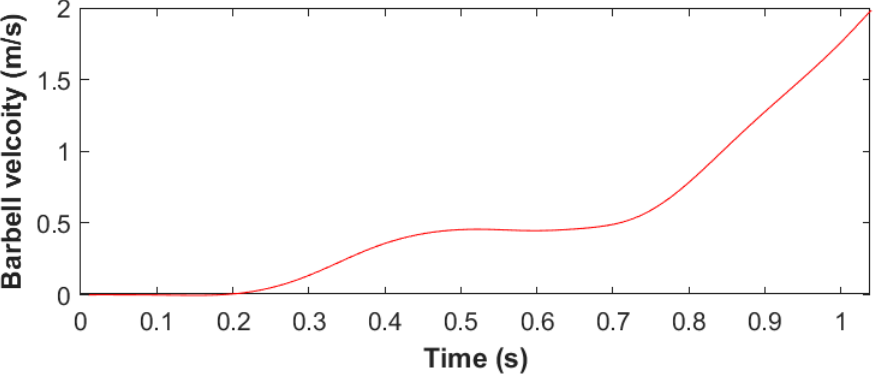
Figure 3. Example of a velocity–time graph profile with two peaks for participant F1 while perform- ing a snatch. a